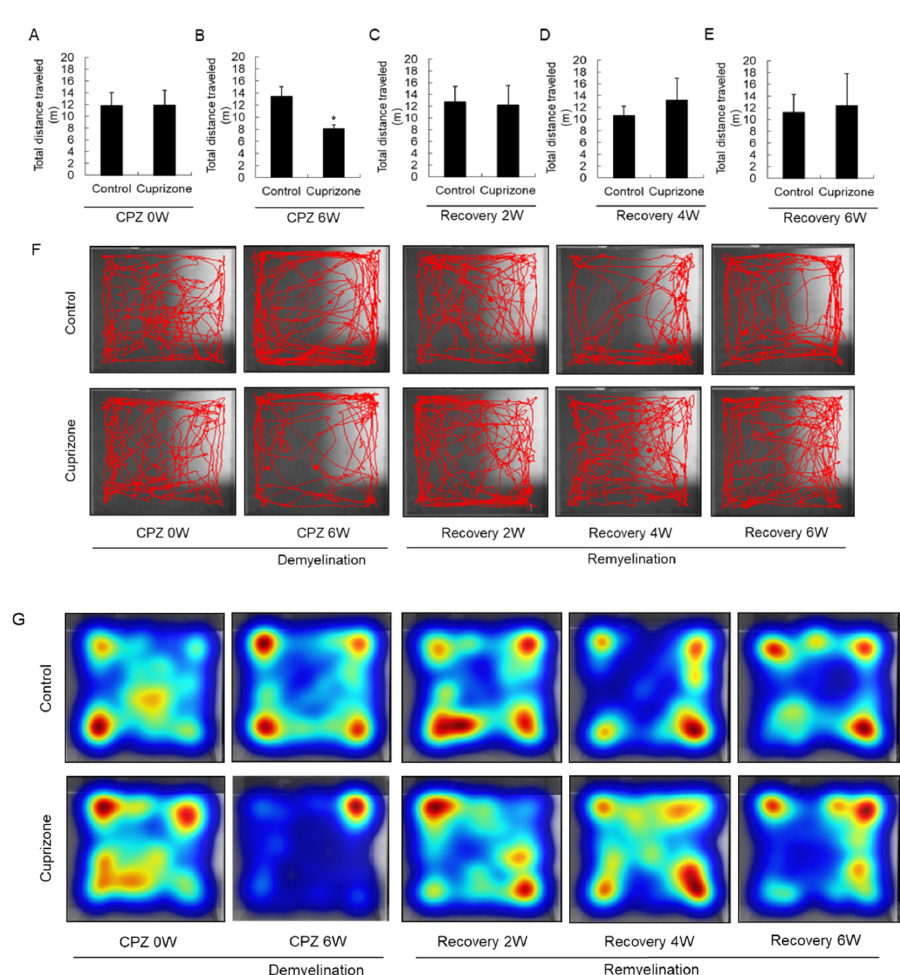
Figure 4. Open-field behavior. ( A – E ) The graphs show the total distance traveled in an open field during 5 min. Data are expressed as mean ± standard deviation (SD). The final data was made with the results of the total individuals minus the number of sacrificed mice. N = 7 for each group, and differences between groups are expressed as * p < 0.05. ( F ) Representative images showing typical examples of exploratory behavior in the open-field test in the control and cuprizone groups. ( G ) The heatmap visualizations were similar to the above results.